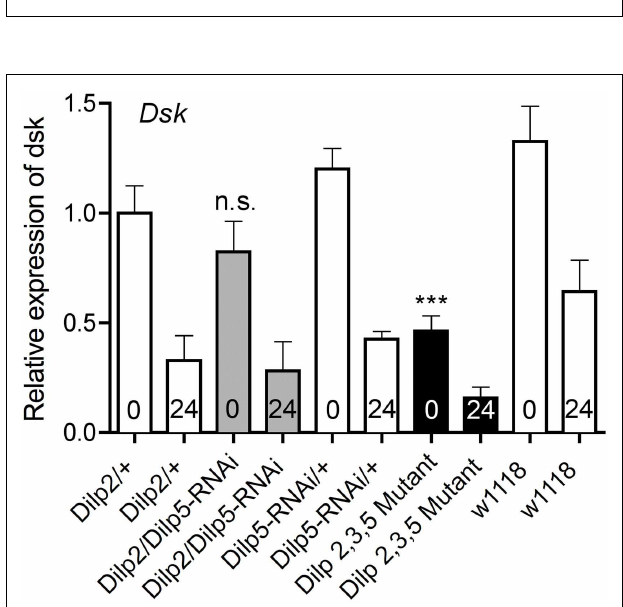
FIGURE 7 | Relative expression levels of Dsk transcripts in Dilp deficient files. The Dsk transcript levels decreased significantly in normally fed Dilp2,3,5 mutants (black bar) compared to controls (white bars; *** p < 0,001, One-way ANOVA, n = 10 for each genotype, assays run in